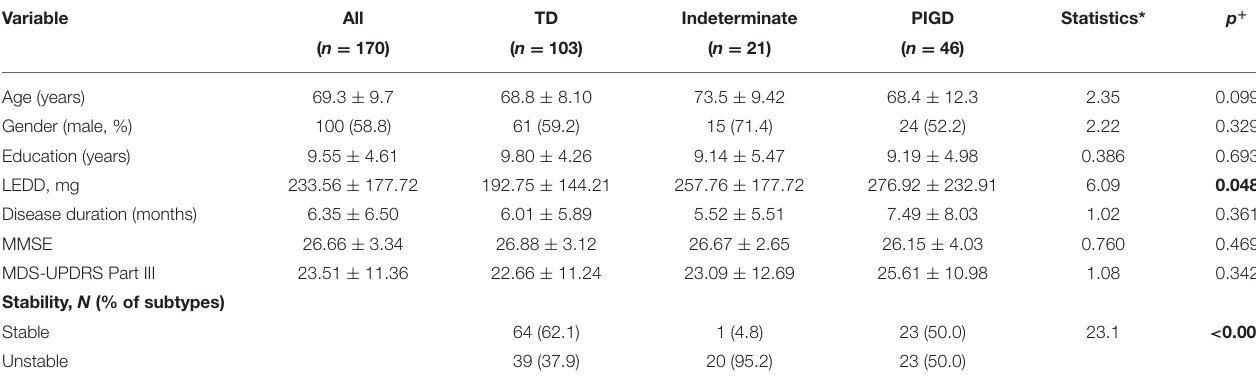
TABLE 1 | Baseline variables of subtypes and their stability at 3